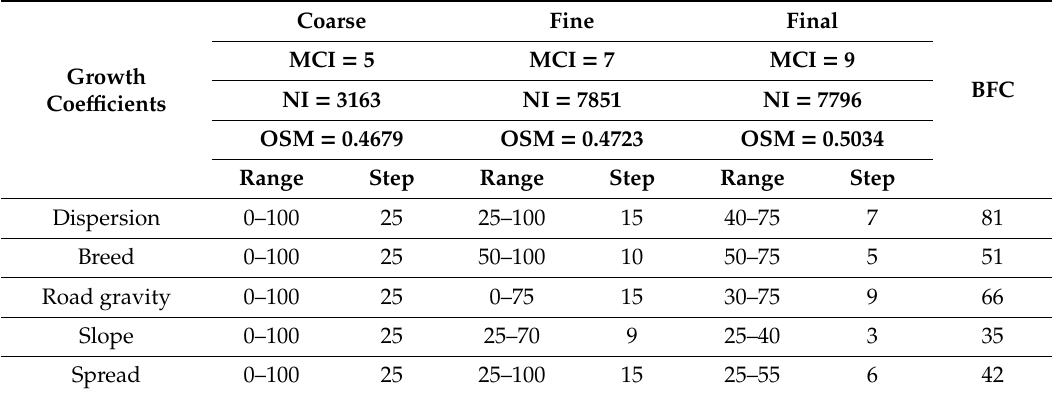
Table 2. Calibration coe ffi cients for the SLEUTH